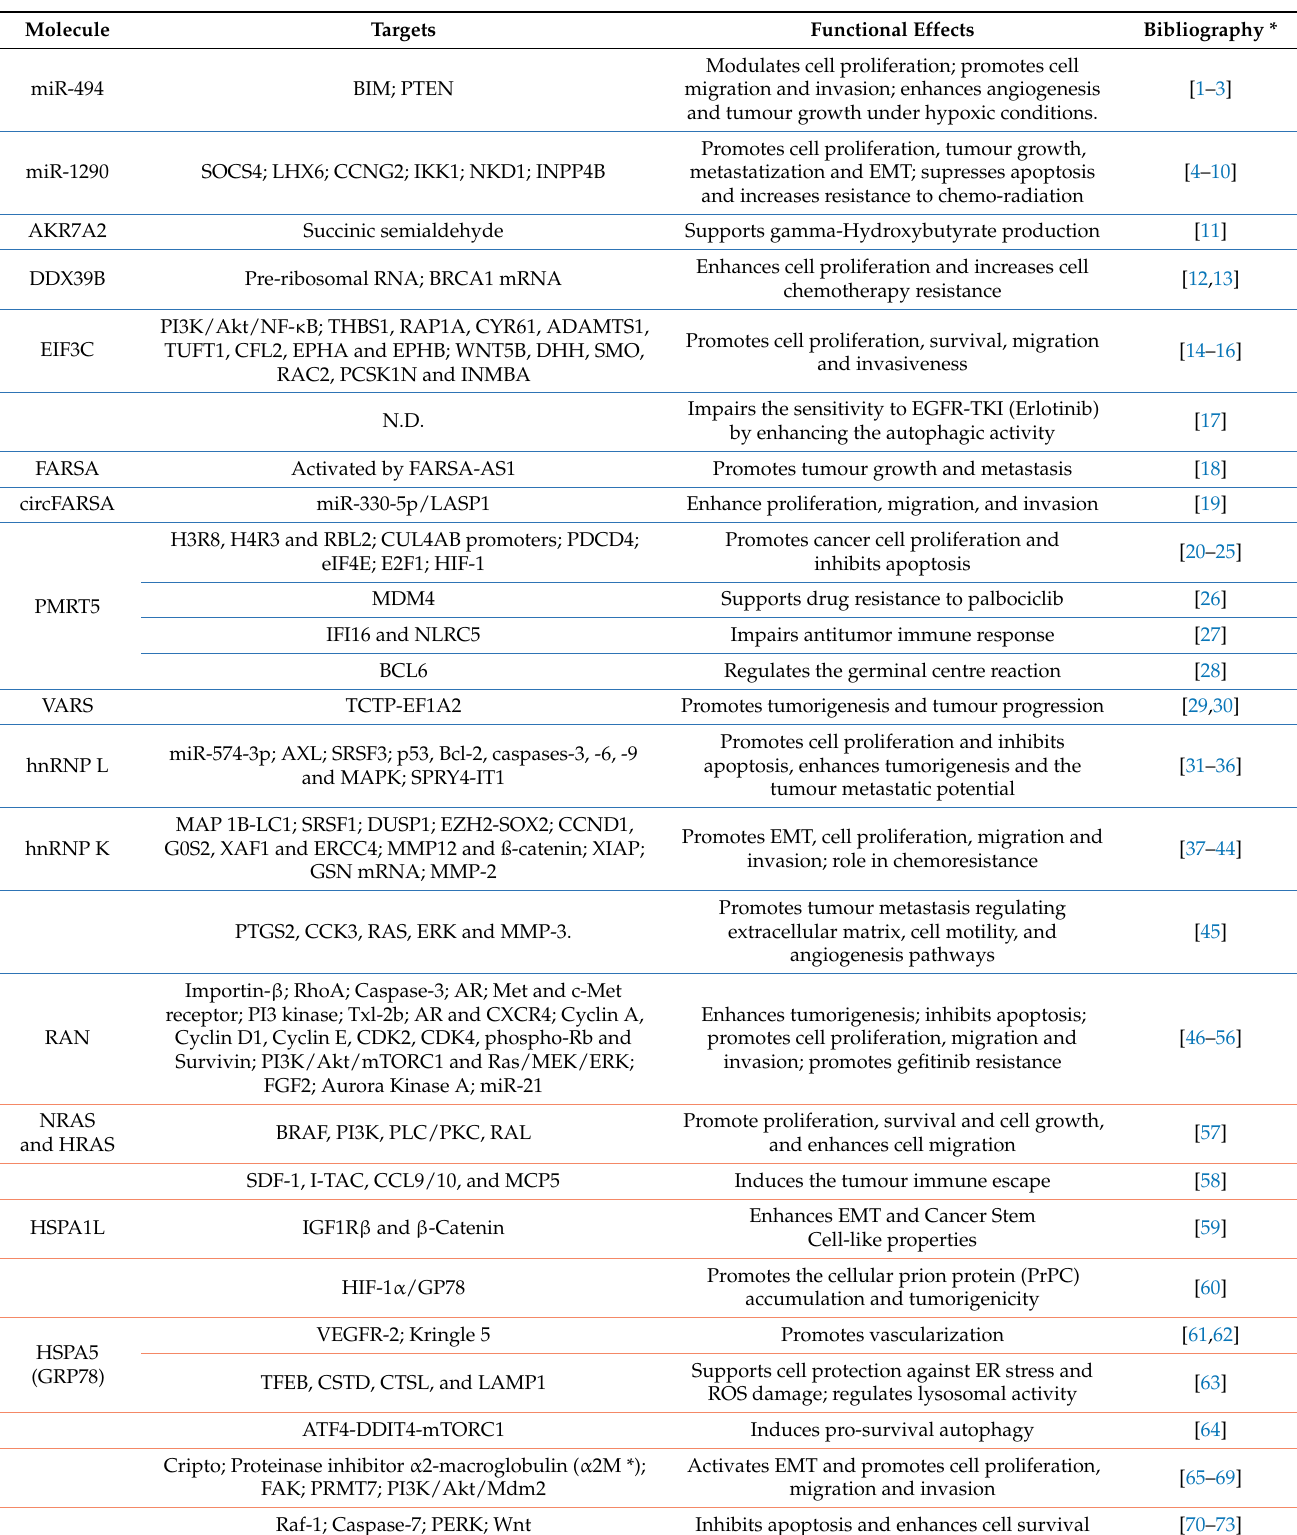
Table 1. Molecules upregulated in acidic and hypoxic Mexo. List of molecules upregulated in exosomes secreted in hypoxic (blue) and acidic (orange) TME. Targets and functional effects on tumour progression are described in several tumour types as reported in References. N.D., not detected targets, * Refer to Supplementary Data S1 for the specific reference